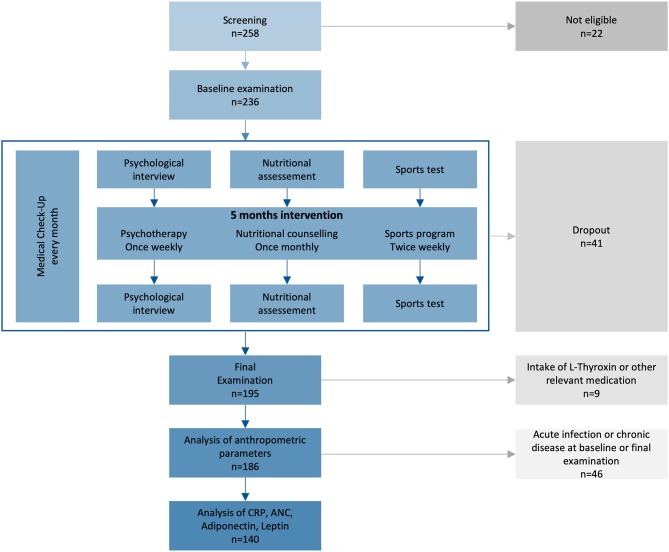
Study plan of the prospective intervention study. From 2014–2017, 236 children from 10–14 years with primary overweight or obesity were included, if they were willing and psychologically and physically capable for the intervention. ANC, absolute neutrophil count; CRP, C-reactive protein.